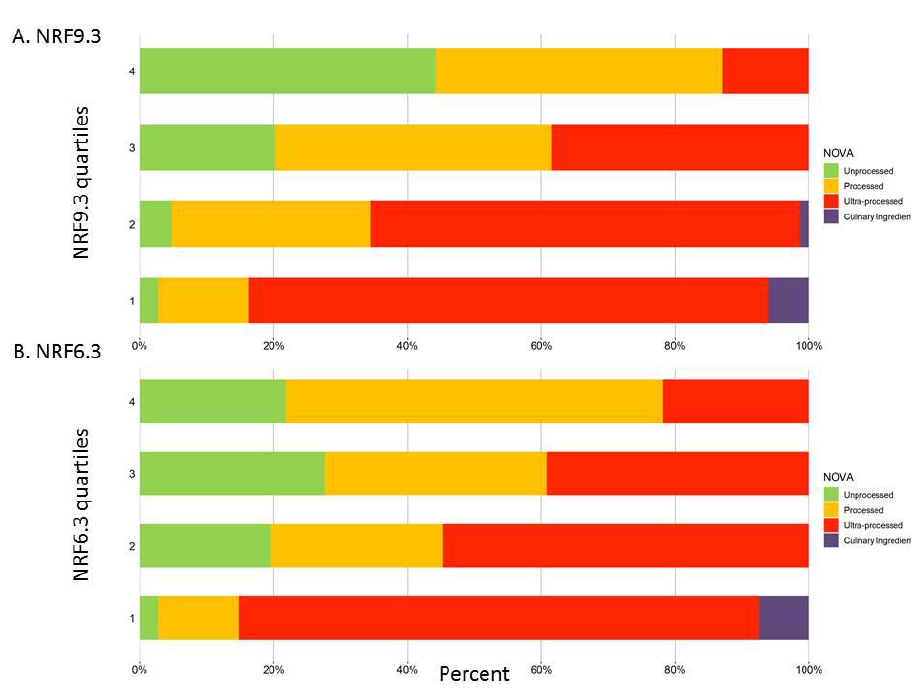
Figure 4. Nutrient density scores distribution by NOVA categories. ( A ) NRF9.3 quartile distribution by NOVA categories; ( B ) NRF6.3 quartile distribution by NOVA categories.